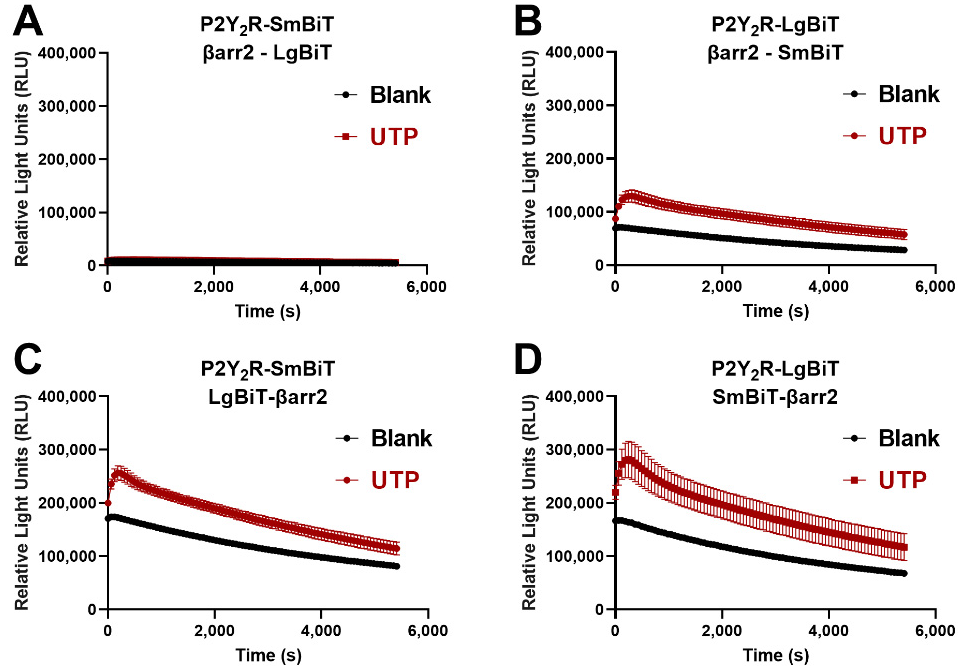
Figure 2. Selection of the optimal configuration of constructs of the P2Y 2 R and β arr2 in the NanoBiT ® system. Each panel shows one of the four possible combinations of the P2Y 2 R, C-terminally fused to either LgBiT or SmBiT, and β arr2, C-or N-terminally fused to LgBiT or SmBiT: ( A ) P2Y 2 R-SmBiT